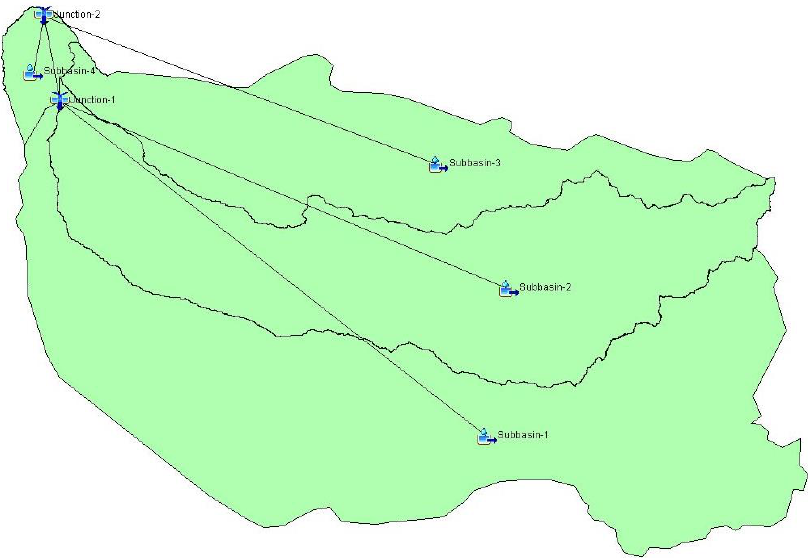
Figure 4. Catchment diagram used in HEC-HMS for the hydrologic modeling.